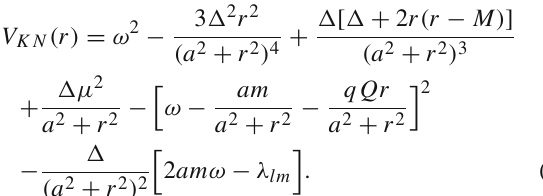
Fig. 1, V a ( r ) may represent V ( r ) well for very large r ≥